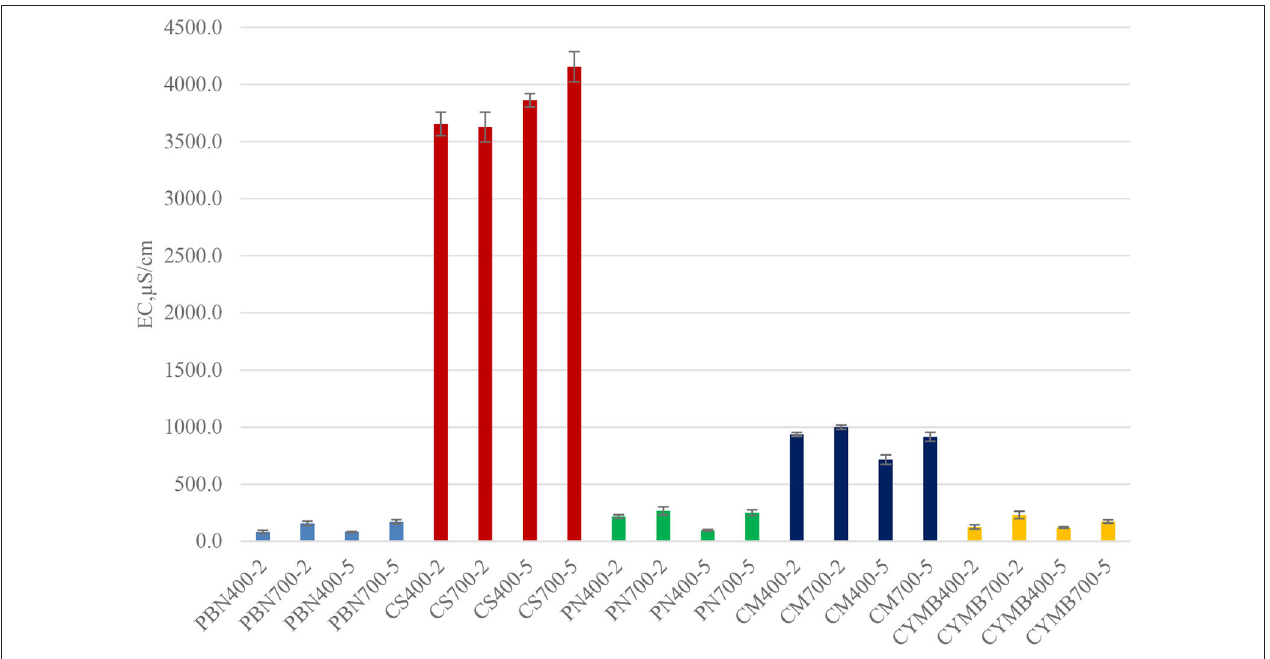
FIGURE 2 | Conductivity (EC) of biochar produced under different initial conditions (400 and 700 ◦ C; 2 and 5h).